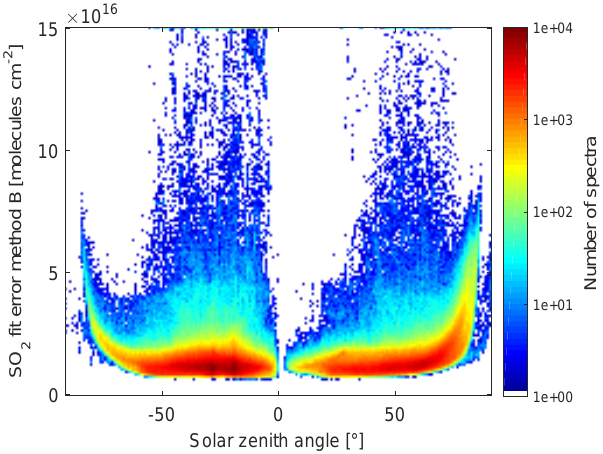
Figure 14. Histogram of the SO 2 DOAS fit error from the solar atlas evaluation as a function of solar zenith angle for instrument